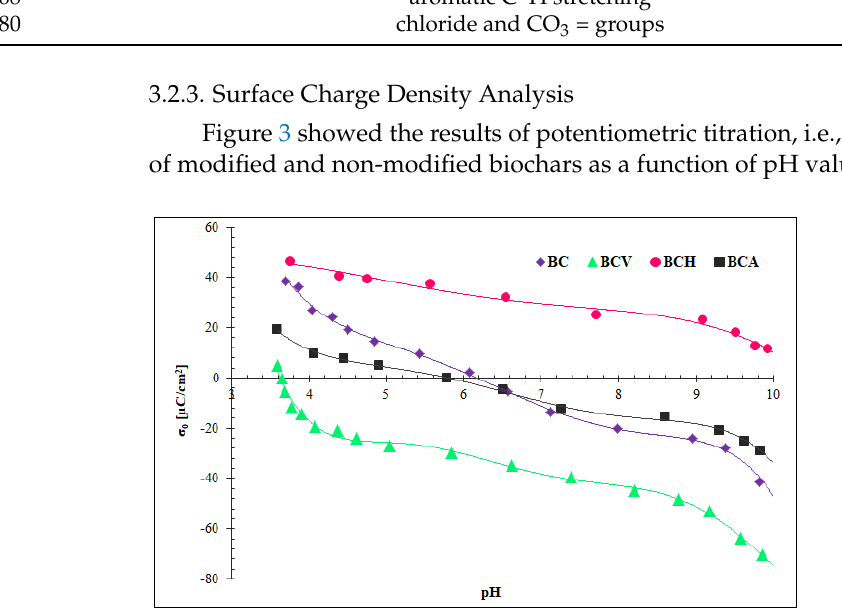
Figure 3. Influence of biochar modification on its surface charge density (σ 0 ).